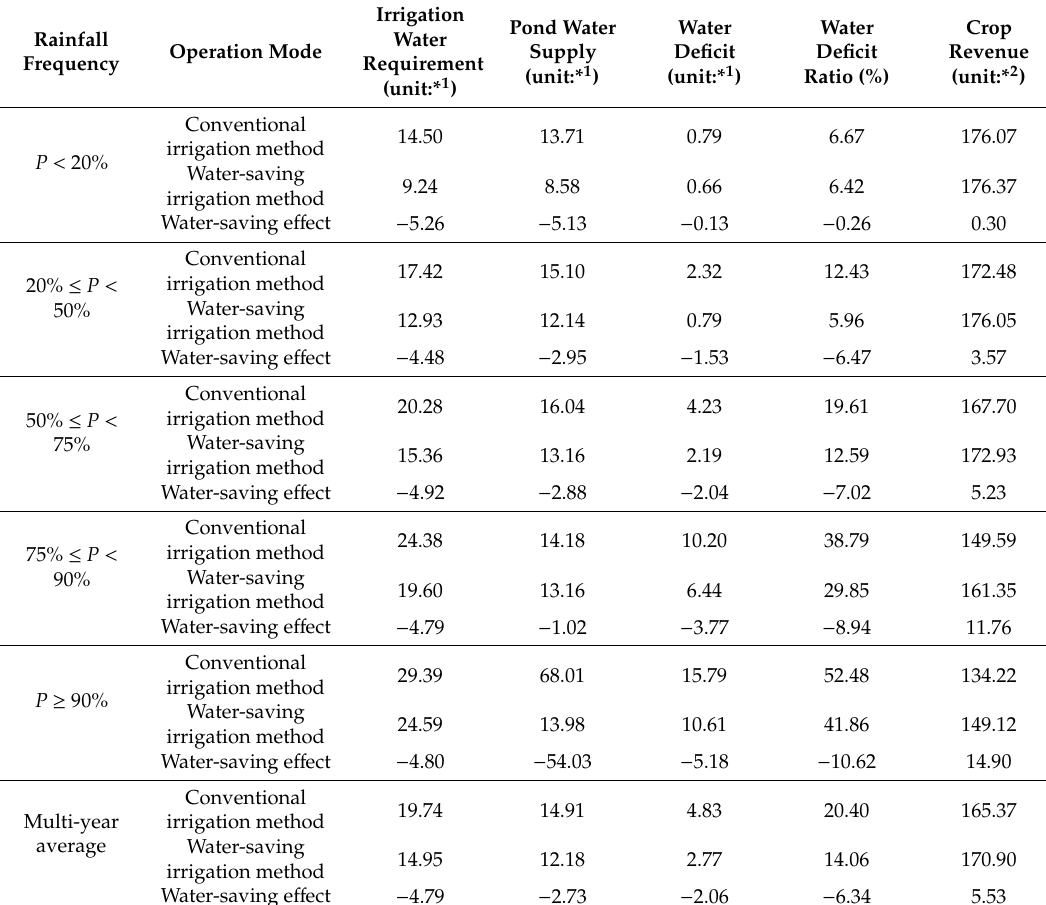
Table 2. Crop water deficits and deficit ratios under conventional and water-saving irrigation methods in the pond irrigation district of Yangdian Town.